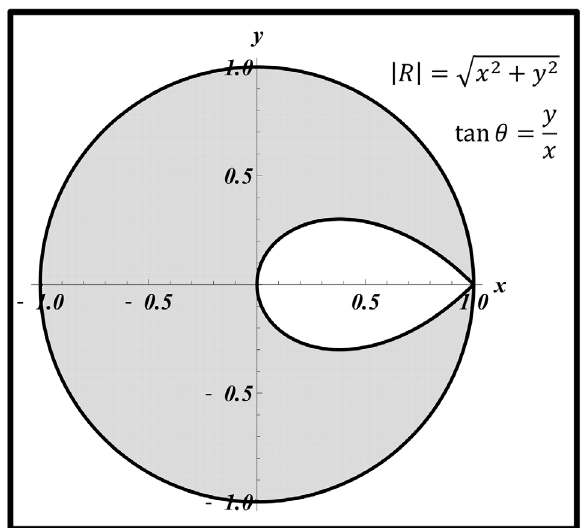
Figure 11. The grey area is the region where increasing wave reflection is beneficial. In this region, increasing wave reflection results in a decrease of the input pulsatile power ( R j j : [ P pulse ; ). In the white region, increasing wave reflection is disadvantageous and results in an elevation of the pulsatile power ( R j j : [ P pulse : ).